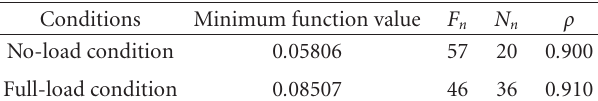
Table 5: Best results after feature selection and network optimiza- tion using